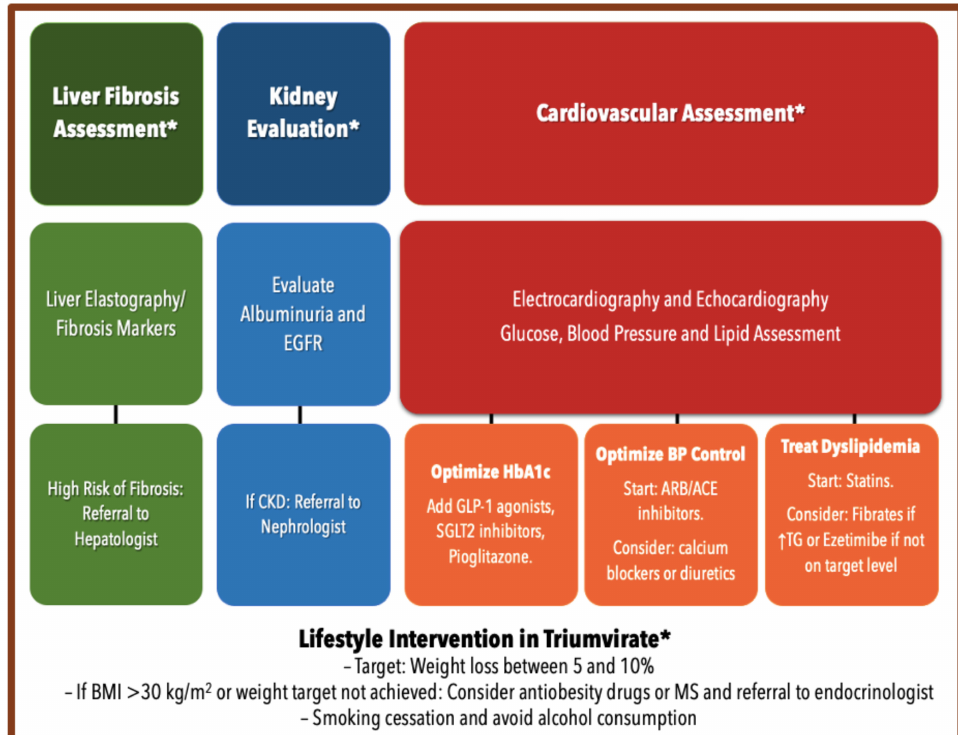
Figure 2. Assessment and Treatment of Non-alcoholic Fatty Liver Disease in Type 2 Diabetes. ACE: Angiotensin converting enzyme; ARB: Angiotensin-II receptor antagonists or blockers; BMI: body mass index; EGFR: estimated glomerular filtration rate; GLP-1: Glucagon-like Peptide-1; MS: Metabolic surgery; SGLT2: Sodium-glucose cotransporter 2; TG: Triglycerides; * Triumvirate Lifestyle